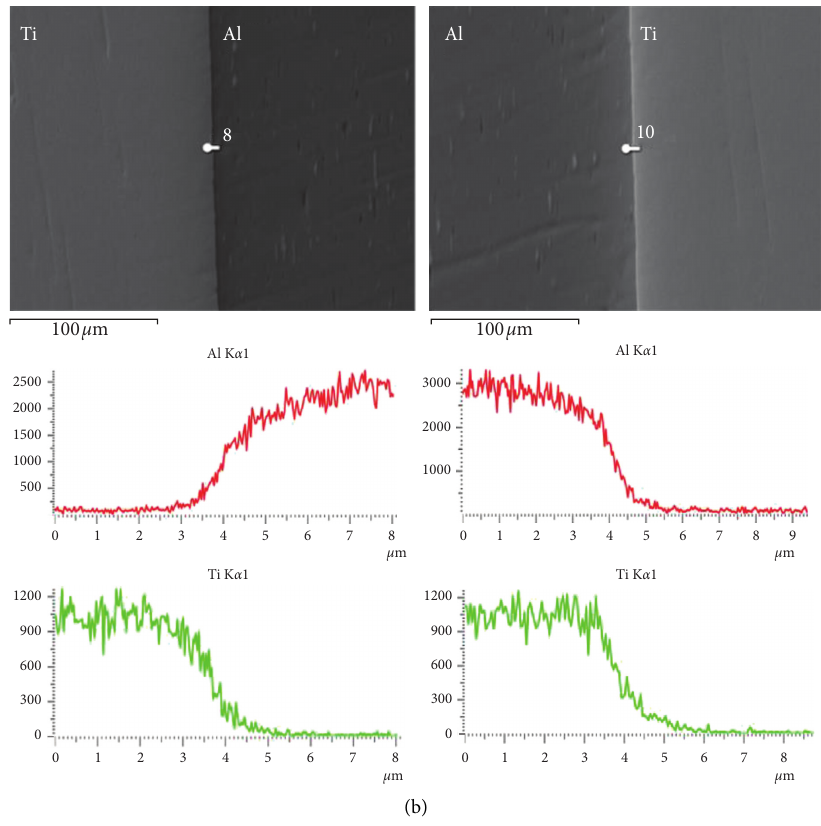
Figure 13: The morphology and the energy spectrum of (a) S5 and (b)